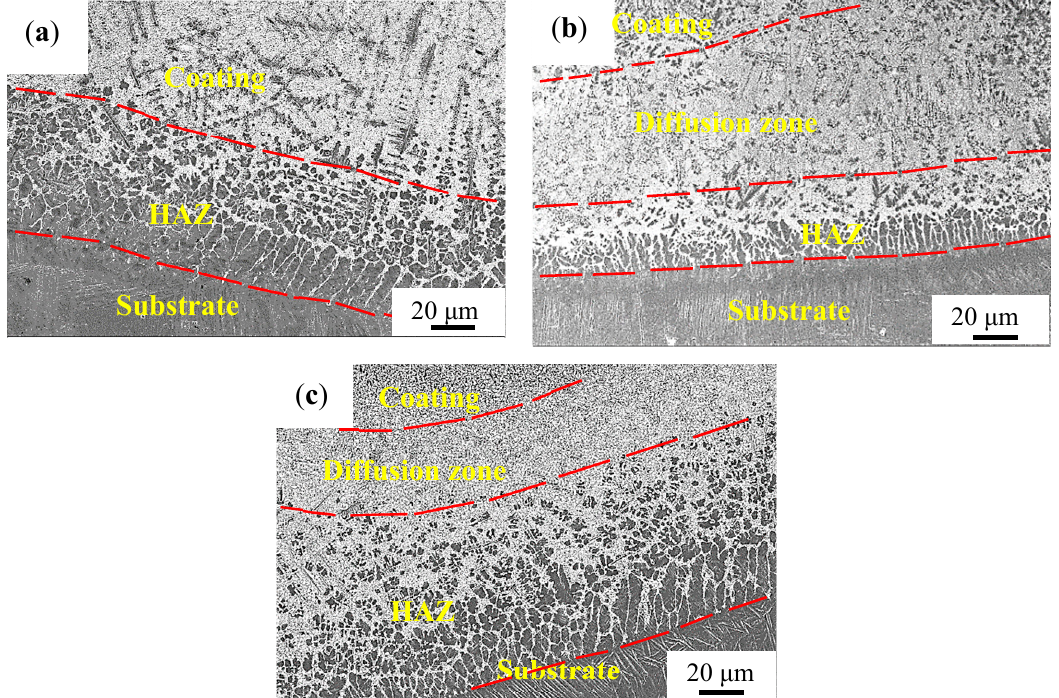
Figure 4. Micrographs at the bottom of the coatings on the cross section. ( a ) Ti-Al-Si, ( b ) Ti-Al-Si-6TiC and ( c ) Ti-Al-Si-10TiC.